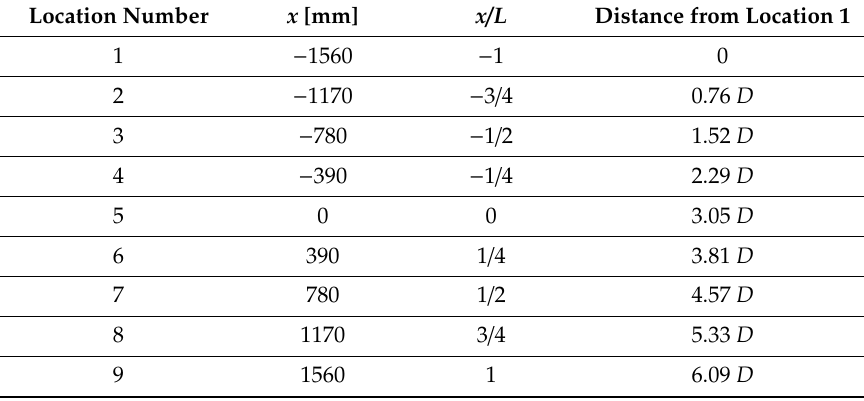
Figure 5. A schematic diagram of the measurement setup. ( a ) Configuration A: No wind turbine over the hill; ( b ) Configuration B: Wind turbine at − L over the hill; ( c ) Configuration C: Wind turbine at − L over a flat terrain. Table 1. Measurement locations of wind speed profiles along the x